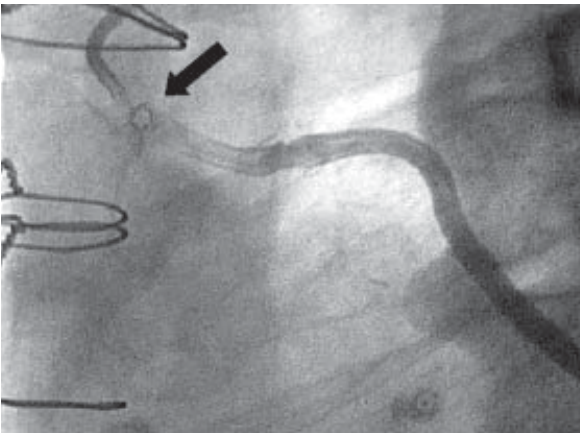
Fig. 6 – Post-operative angiographic study of a patient submitted to an anastomosis saphenous graft to the diagonal branch utilizing a mechanical suture. N.B. observe the metallic device.